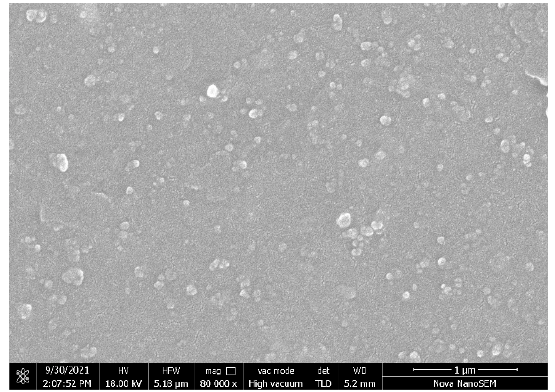
Figure 1. FESEM image of the cross section of VR60 indicating uniformity in the distribution of CB.